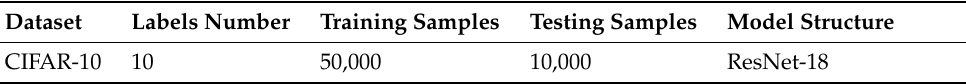
Table 1. Comparative analysis of attacks with different attack